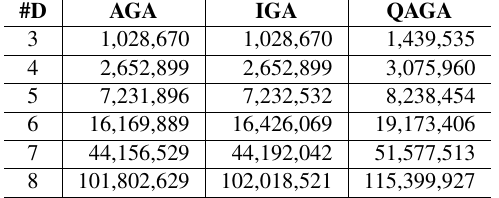
Table 5. Comparison of the total costs of three